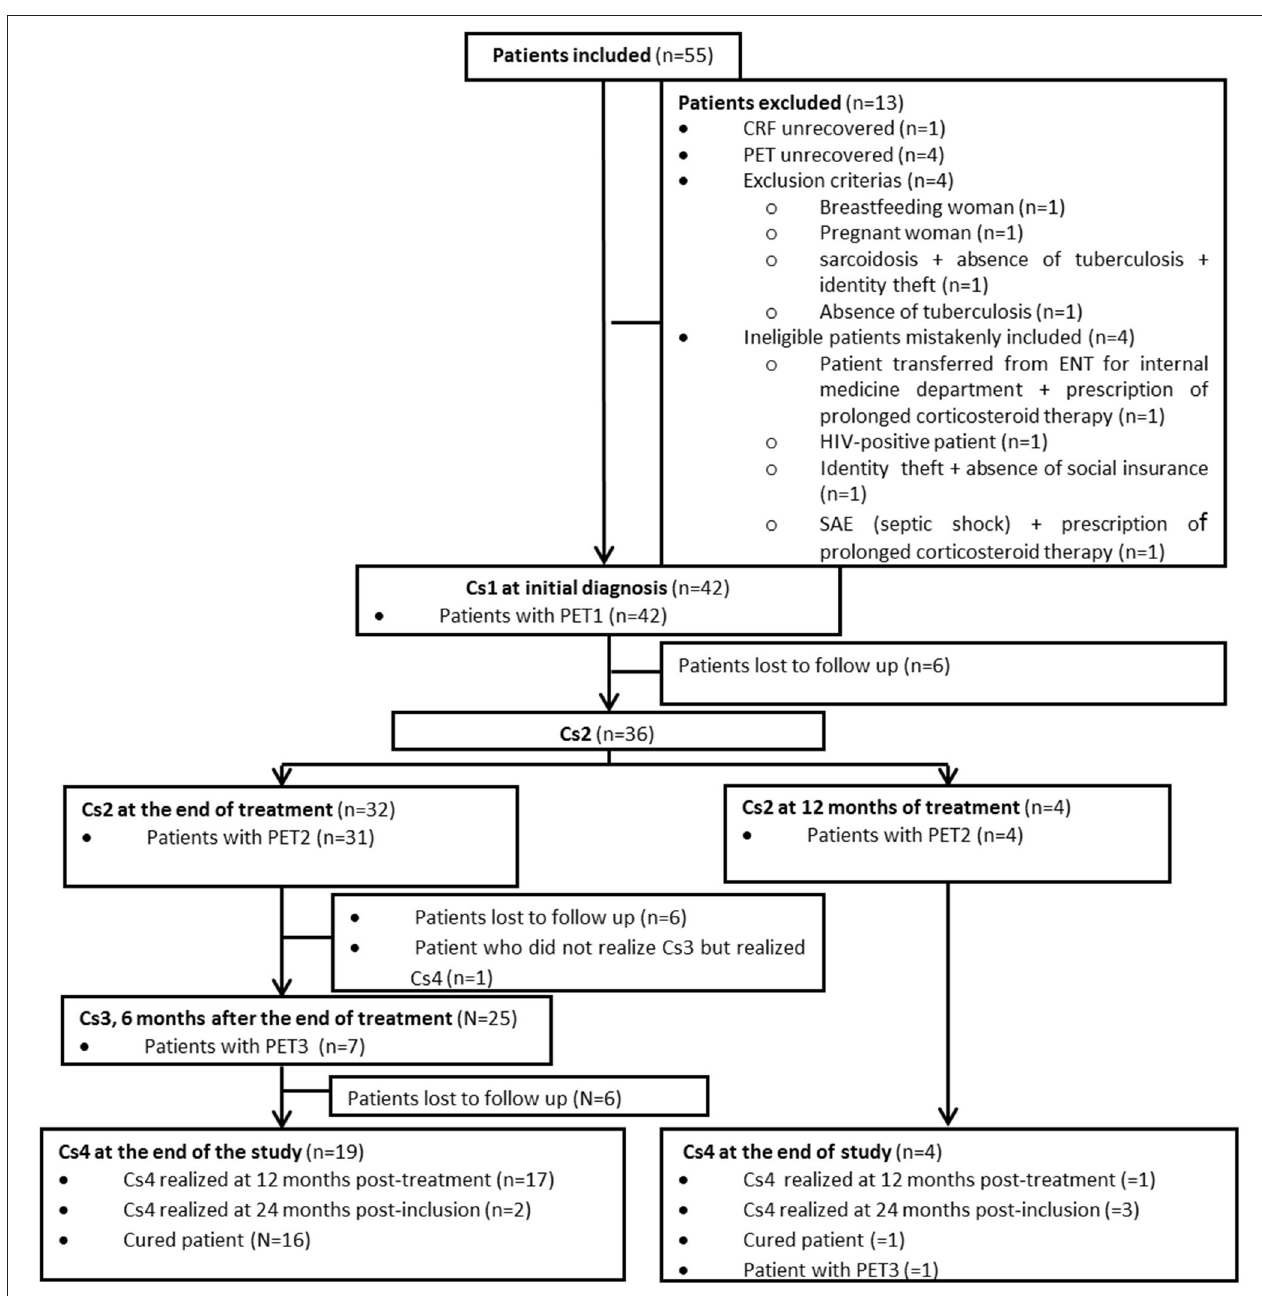
FIGURE 1 | Flowchart of the study. Cs, medical consultation; PET1, Pet performed at initial diagnosis; PET2, PET performed at the end of treatment; PET3, PET performed 6 months after the end of